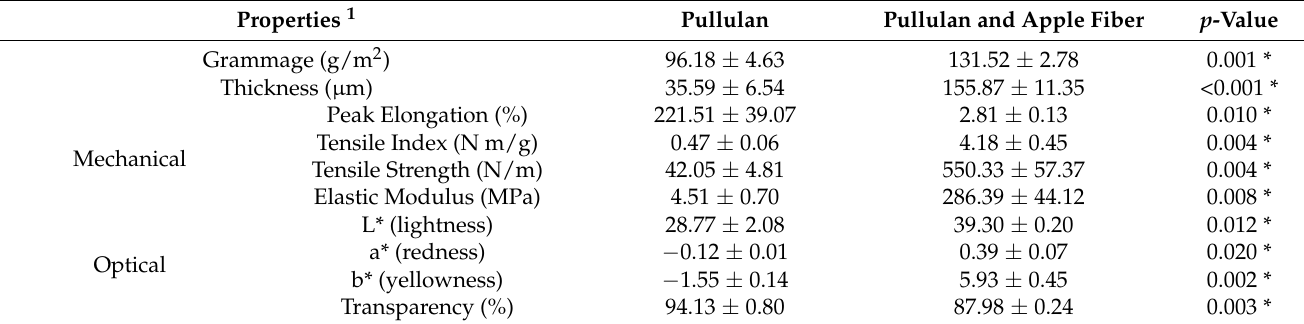
Table 1. Grammage, thickness, mechanical, and optical properties of the biocomposite films. Properties